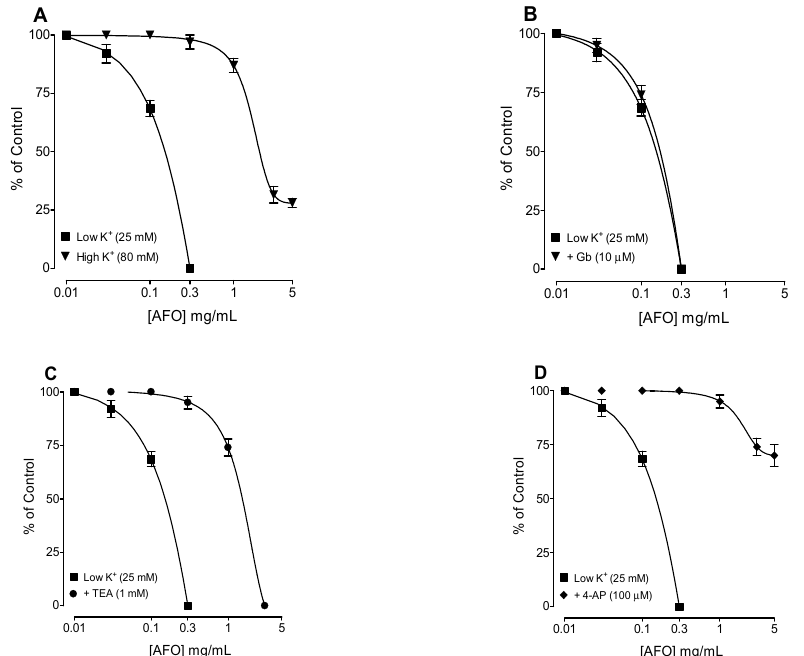
Figure 6. Concentration-dependent inhibitory effects of the essential oil (AFO) against ( A ) low K + and high K + , and low K + in the presence of ( B ) glibenclamide (Gb; 10 µ M), ( C ) tetraethylammonium (TEA; 1 mM) and ( D ) 4-aminopyridine (4-AP; 100 µ M) in isolated guinea pig tracheal tissues. Symbols represent mean ± SEM; n = 4.